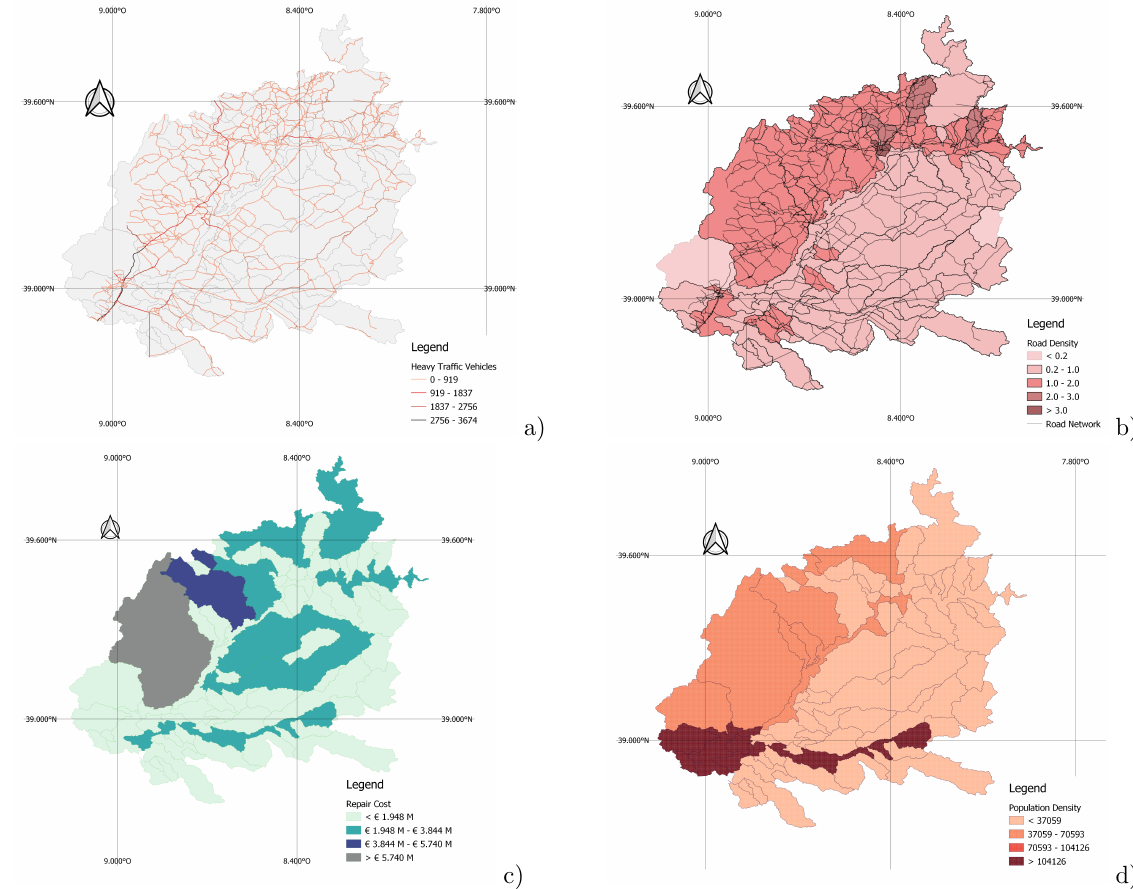
Figure 12. Data collection of infrastructure importance factors: a) Heavy Traffic Vehicles, b) Road density, c) Repair Cost and d) Population